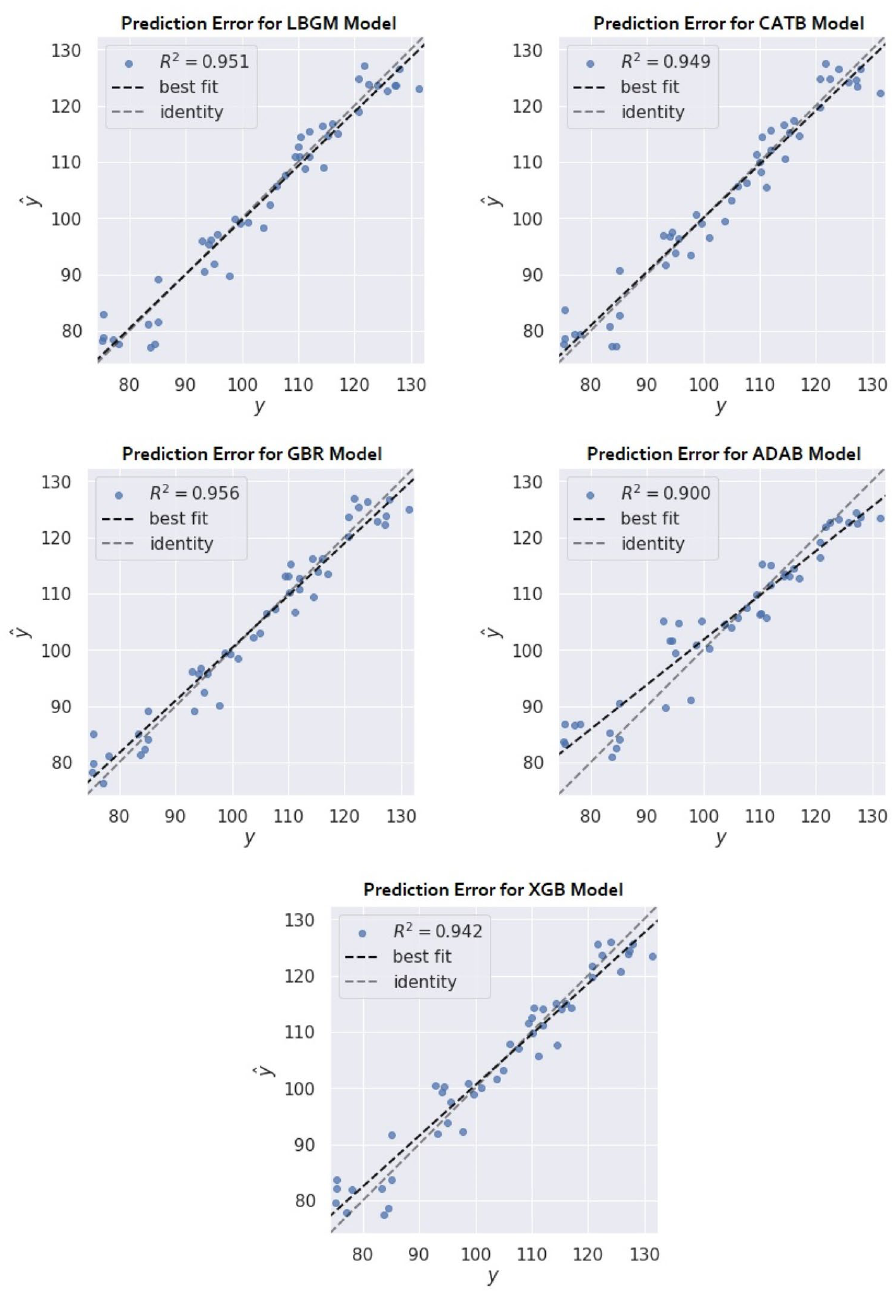
Figure 9. Best fit line for prediction distribution (RS